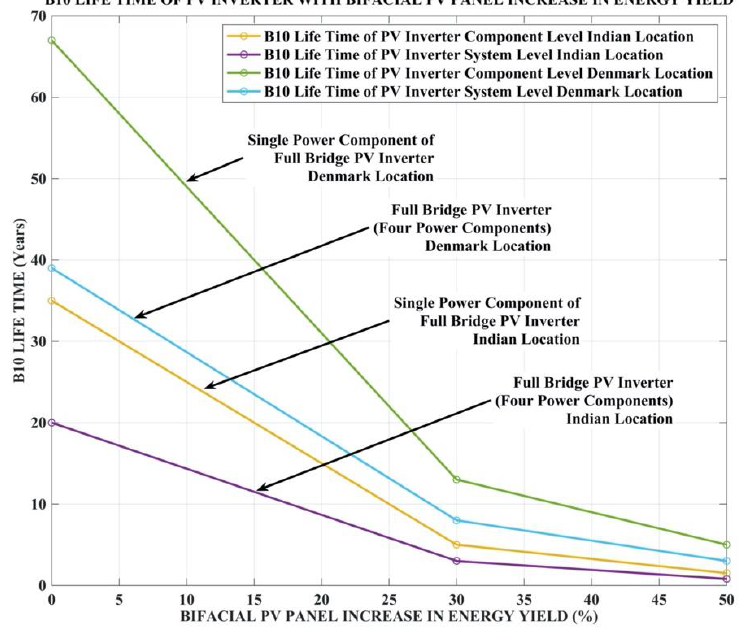
Figure 25. B 10 lifetime vs. bifacial PV panel percentage increase in energy yield.